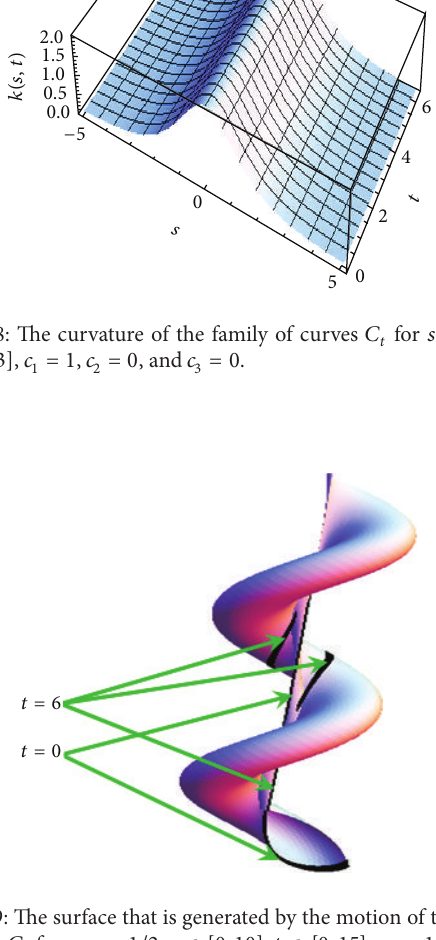
Figure 9: The surface that is generated by the motion of the family of curves 𝐶 𝑡 for 𝜏 0 = −1/2 , 𝑠 ∈ [0,10] , 𝑡 ∈ [0, 15] , 𝑐 1 = 1 , 𝑐 2 = −1 , and 𝑐 3 = 0 . The bold black curves in this surface represent the family of curves 𝐶 𝑡 for 𝑡 = 0, 6 .